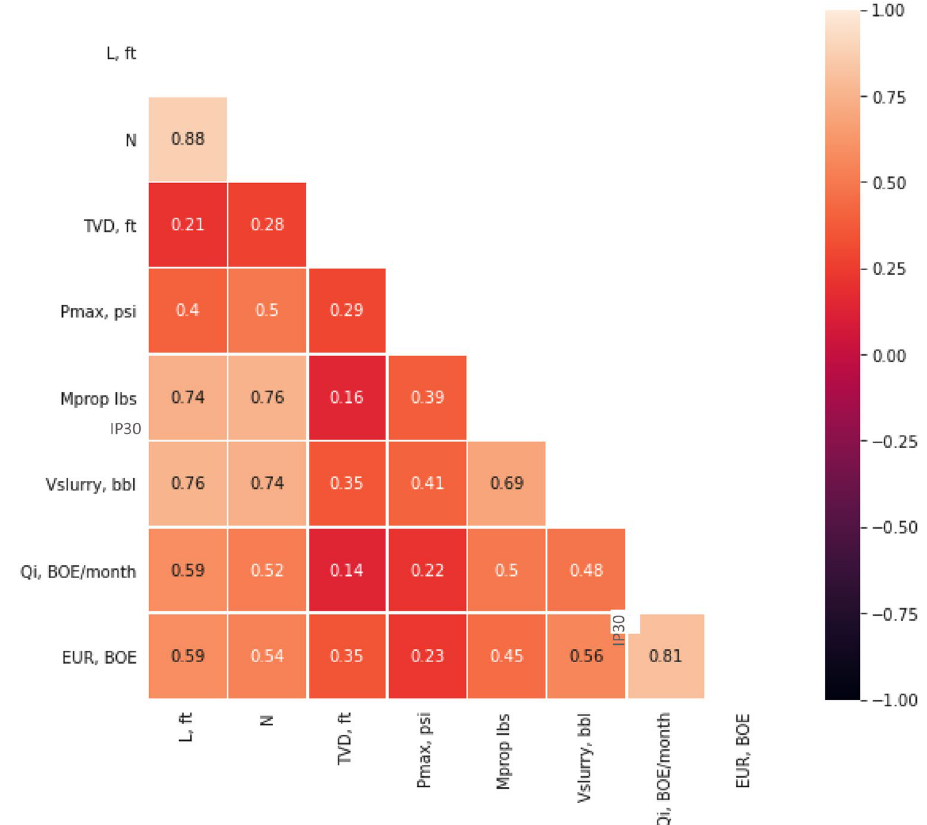
Fig. 2 Heat map for Pearson’s correlation coefficients between the inputs and the EUR and